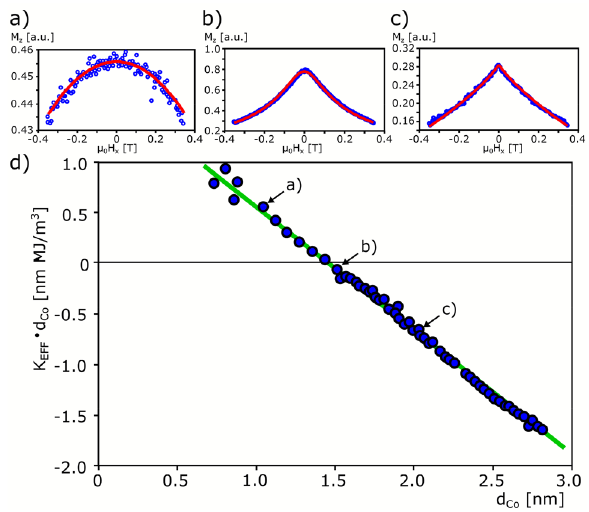
Figure 2. Magnetic anisotropy analysis: ( a – c ) exemplary PMOKE signal dependencies as function of in-plane field under a constant 0.15 T out-of-plane field. Red lines—fitting to the Stoner-Wohlfarth model, for selected d Co = 1, 1.5, 2 nm, respectively. ( d ) K 1EFF d Co vs d Co . Green line—A linear fit to K 1EFF d Co = K V d Co + 2K S provides surface ( 2K S ) and volume ( K V ) magnetic anisotropies. Points ( a – c ) in panel ( d ) correspond to d Co in panels ( a – c ),